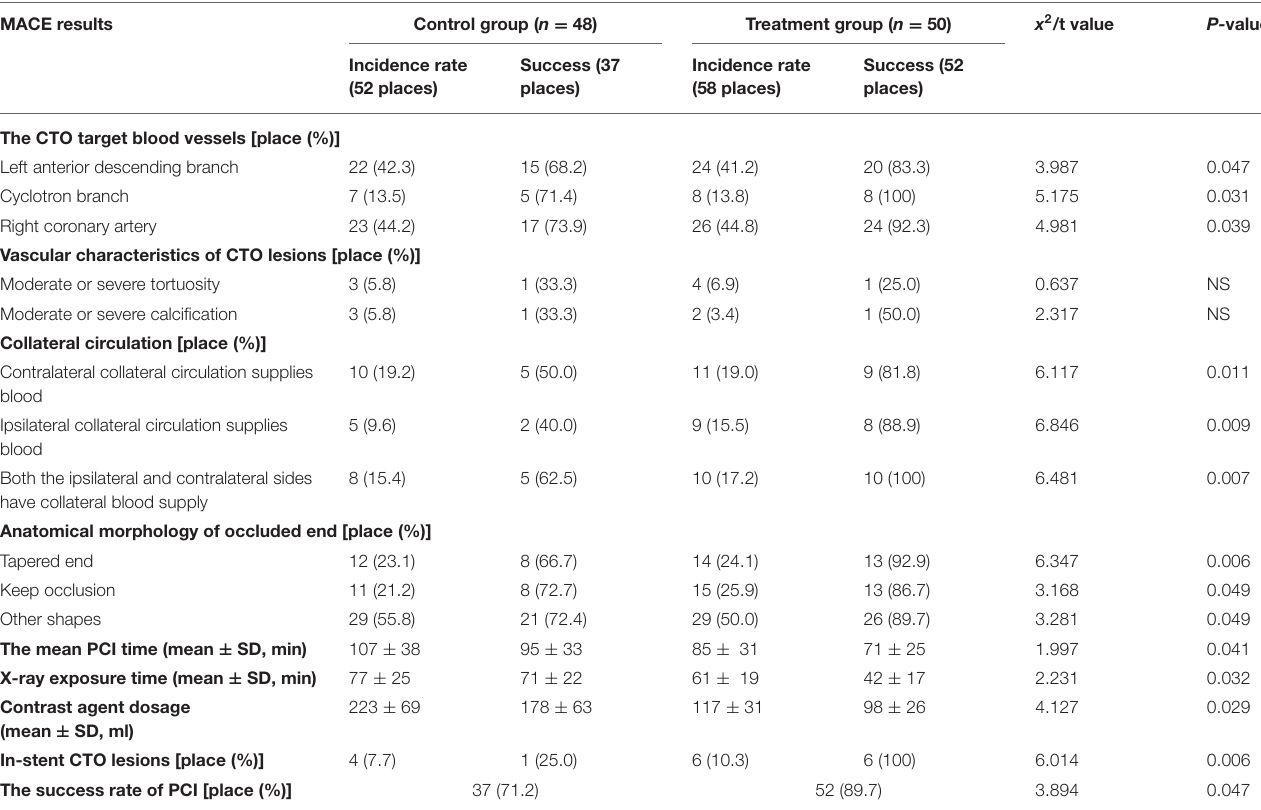
TABLE 2 | Comparison of CTO pathological features and PCI success rate between the two groups. MACE